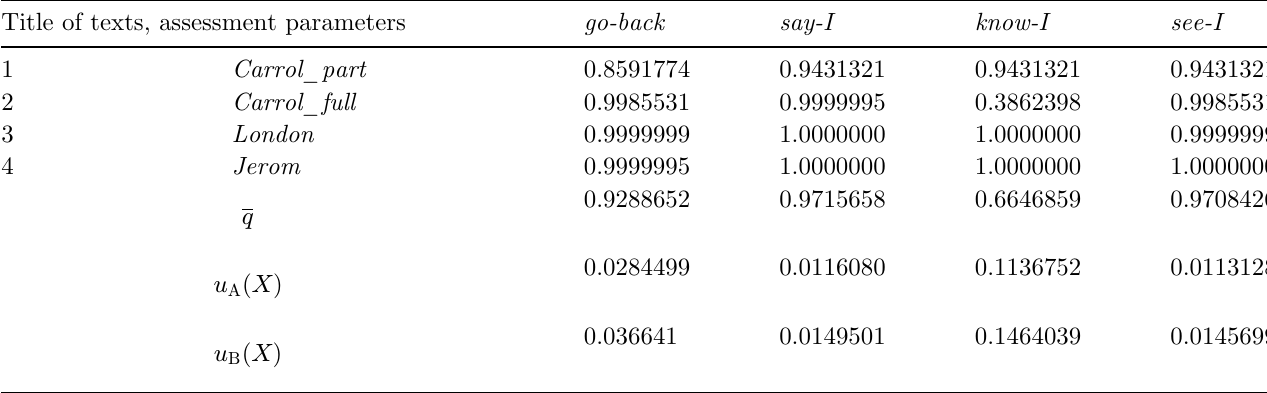
Table 2. Results of uncertainty assessment of the 4 selected language-pair images. Title of texts, assessment